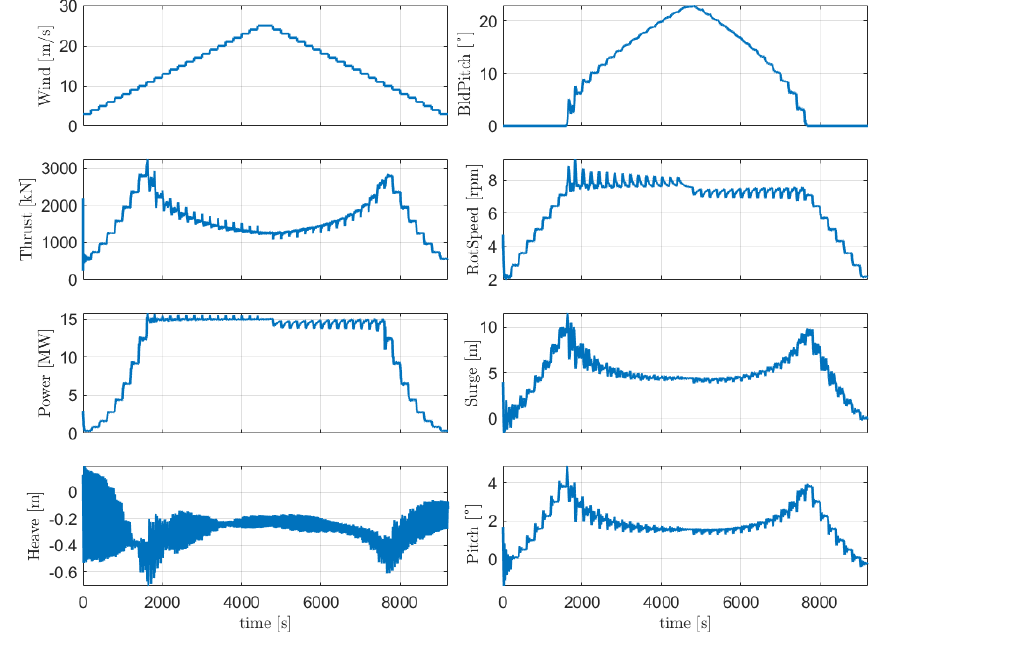
Figure 5. WindCrete response to step wind in the absence of waves.